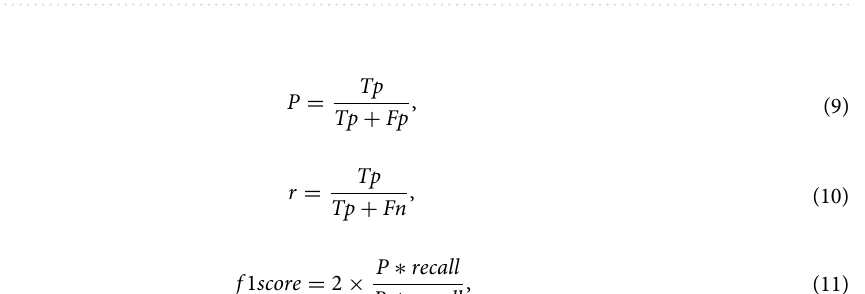
Table 4. Appliance classification case